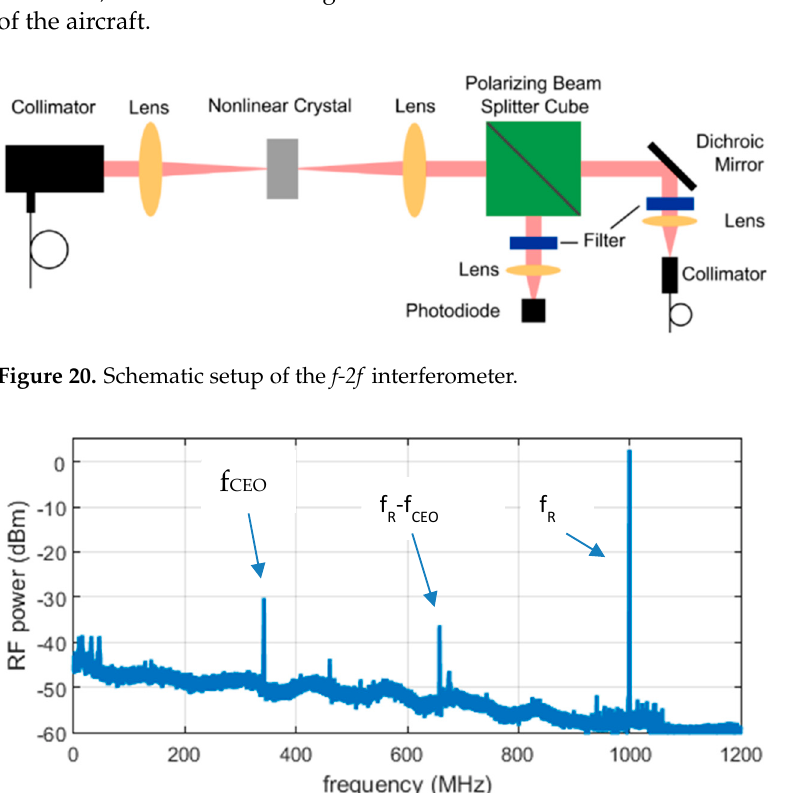
Figure 21. Radio frequency (RF) spectrum of the photodiode signal of the f-2f interferometer showing the carrier-envelope offset frequency (f CEO ) and repetition rate f R signals used for stabilization.